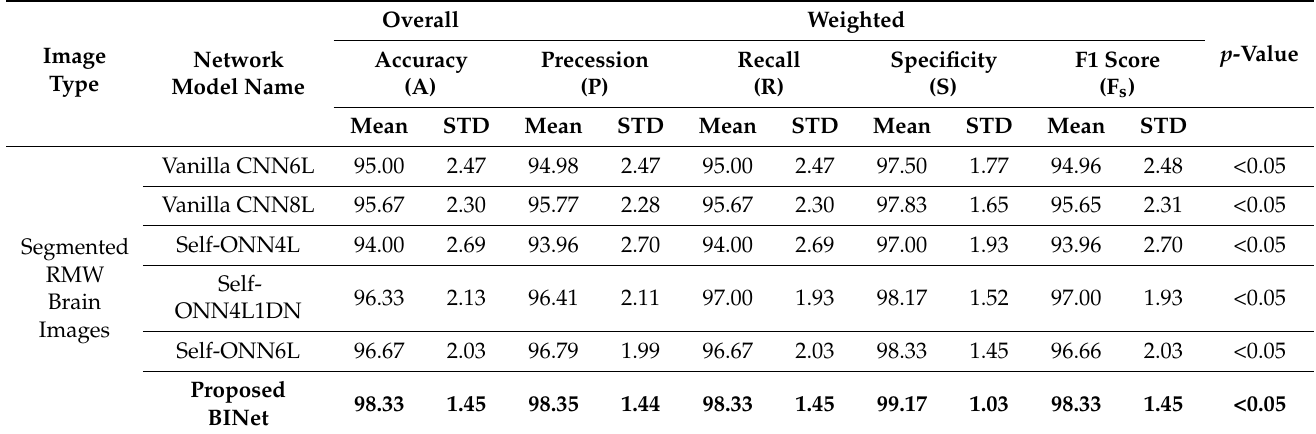
Table 9. Statistical classification results of all models for the segmented RMW brain images. Bold represents the best performing